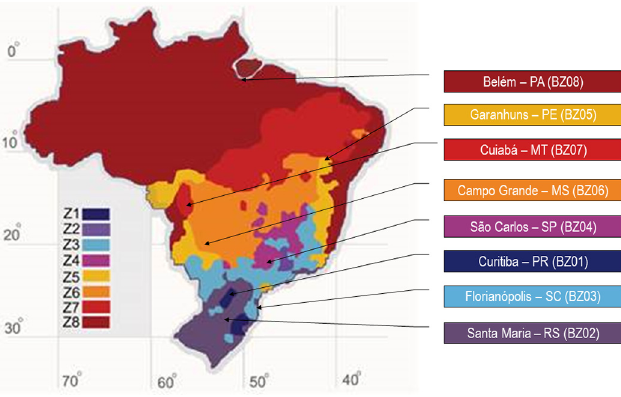
Fig. 5. Brazilian bioclimatic zones and